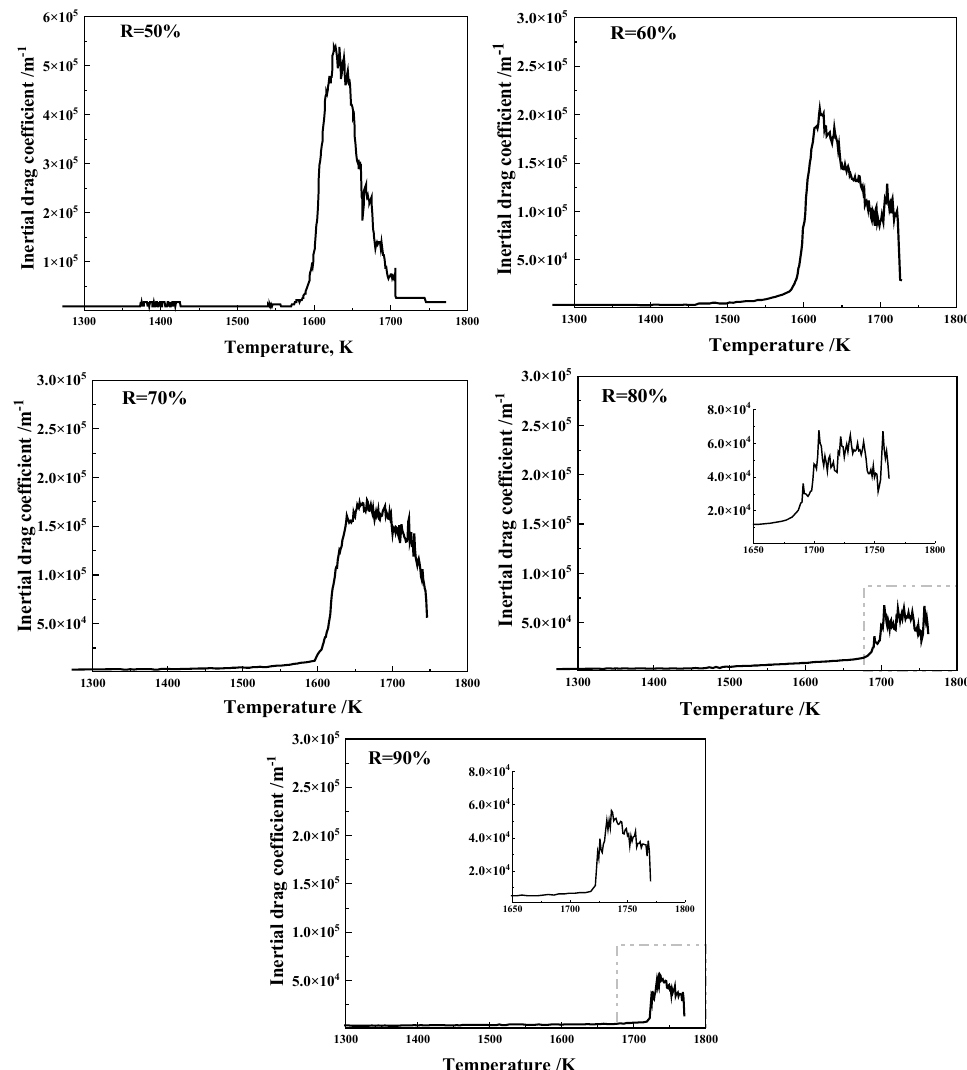
Figure 2. Inertial drag coefficients of different prereduction ores (50%, 60%, 70%, 80%, and 90%).